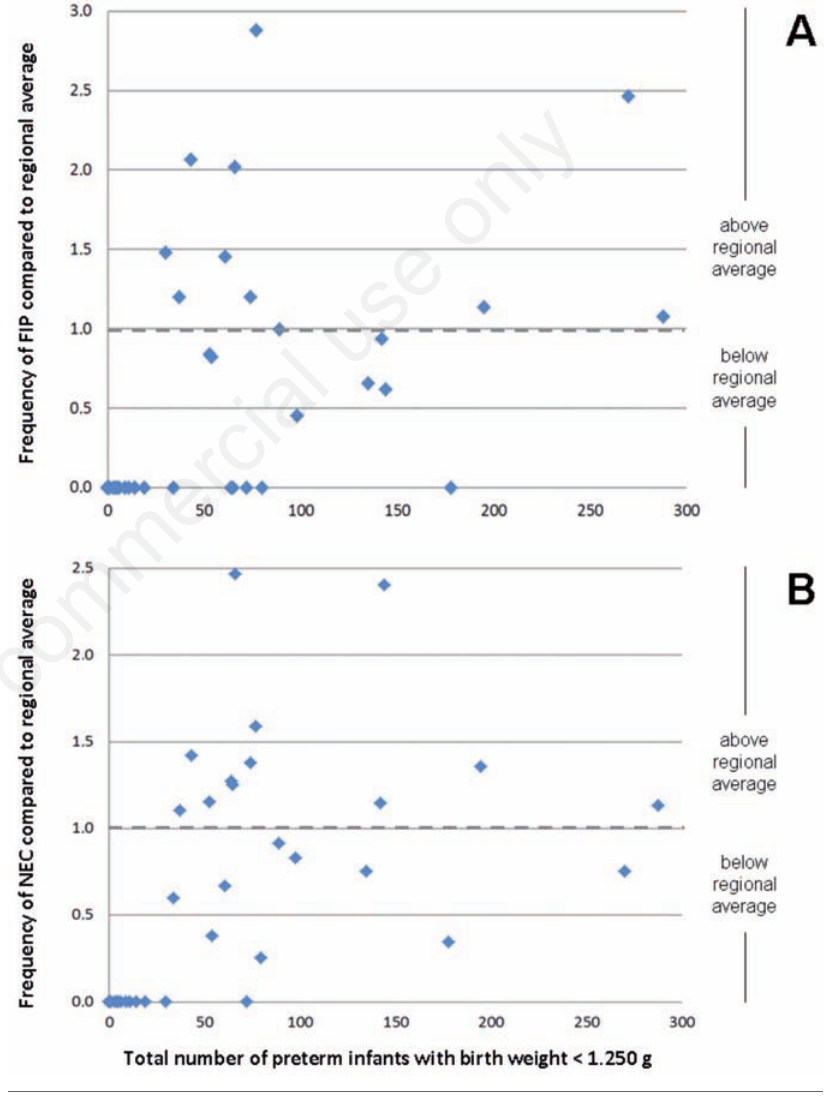
Figure 2. Diagnosis of acquired intestinal diseases in VLBW infants with a BW<1250 g in 37 hospitals in Baden-Württemberg during the years 2010 to 2012. Each diamond repre- sents disease frequency in a single hospital, normalized by the cumulative regional frequen- cy per 100 infants with BW<1250 g (regional average) and depicted as a function of the total number of infants documented in the respective data sets. A) Hospital-specific rates of focal intestinal perforation (FIP), divided by the average regional FIP frequency (2.18%), which is indicated by the broken horizontal line (1.0 value on the Y-axis). B) Hospital-spe- cific rates of necrotizing enterocolitis (NEC), divided by the regional NEC frequency (4.9%), which is indicated by the broken horizontal line (1.0 value on the